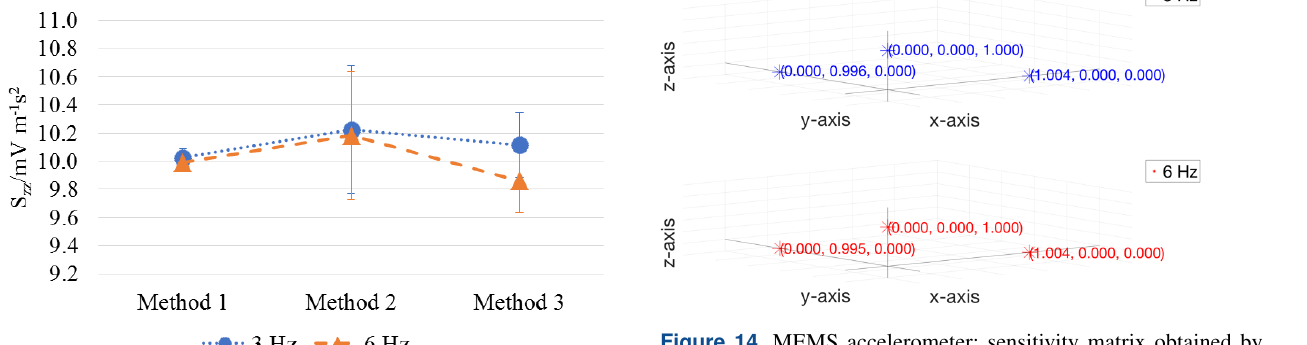
Figure 14. MEMS accelerometer: sensitivity matrix obtained by means of Method 2 (3-D